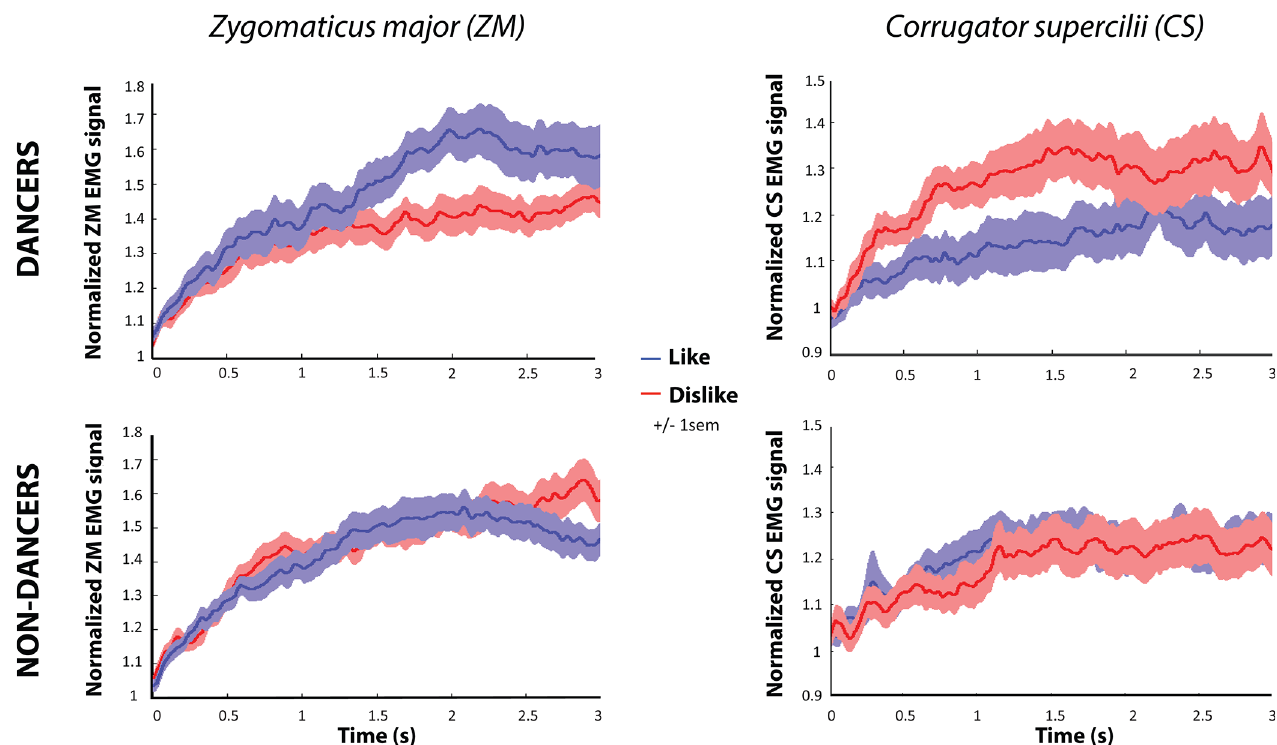
Fig 3. EMG activity across time. Graphs depict changes in EMG traces in standardized units for dancers and non-dancers, for each muscle ( zygomaticus major and corrugator supercilii ), depending on participants ’ subjective liking rating (like/dislike). Shaded regions show +/- 1SEM. For illustration purposes, the condition hypothesized to show a greater response has been visualized on top of the other condition (i.e., blue traces for ZM activity and red traces for CS